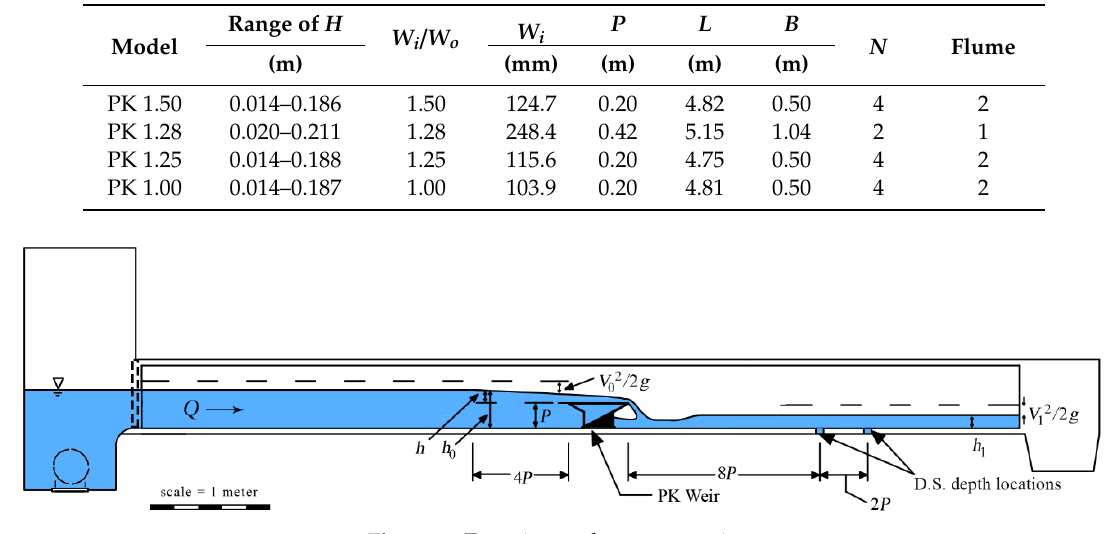
Figure 3. Experimental setup overview.